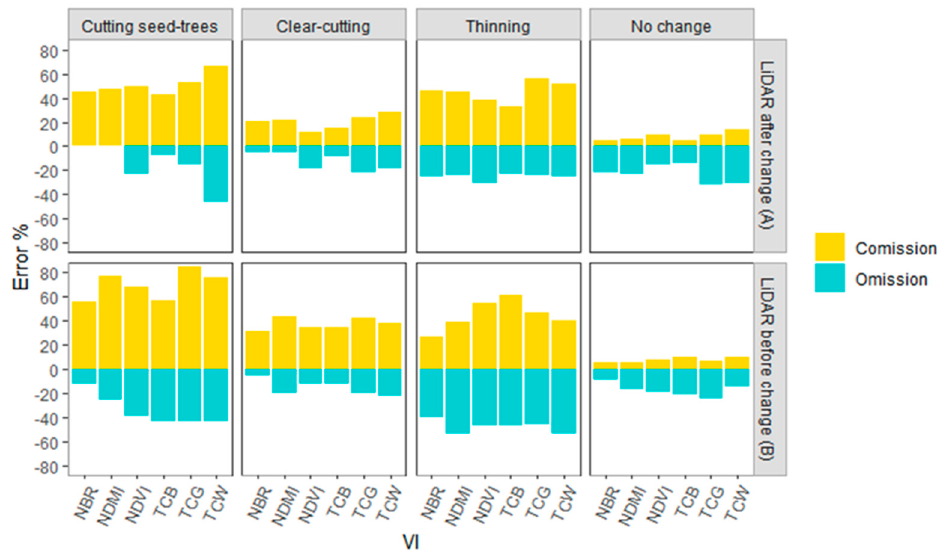
Figure 7. Validation of the change classification performed in the study area for each monitoring period analyzing different VI time series with the BFAST algorithm. ( A ): scenario A , when ALS data were acquired at the end of the monitoring period ; ( B ): scenario B , when ALS data were acquired at the beginning of the monitoring period .